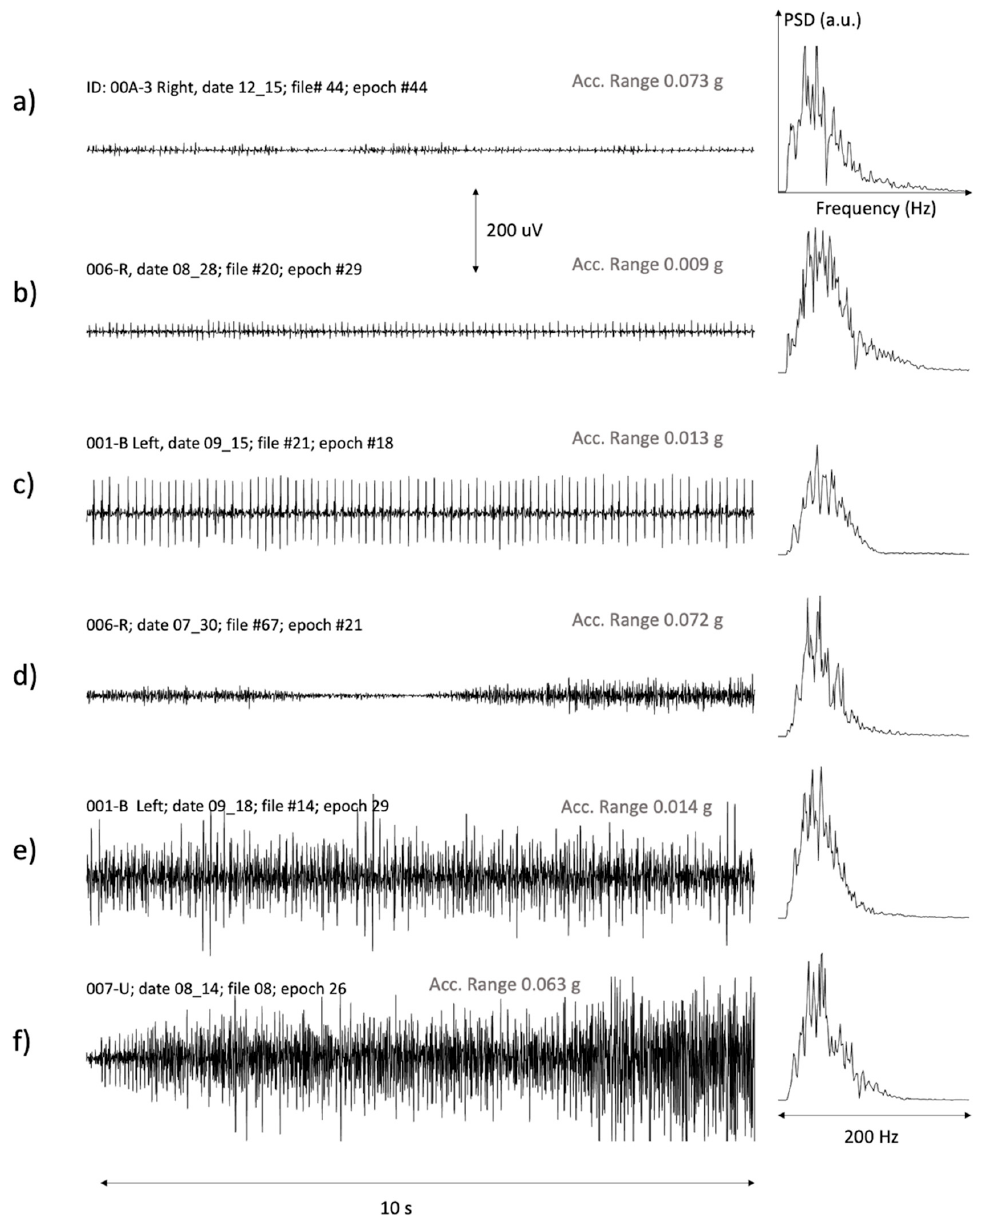
Figure 4. A representative example of good signals from different subjects with: ( a , b ) a few small motor units, ( c ) a large or very superficial motor unit active for a long time, ( d ) variable activation levels with muscle derecruitment followed by further recruitment, ( e , f ) interferential signals involving many motor units.